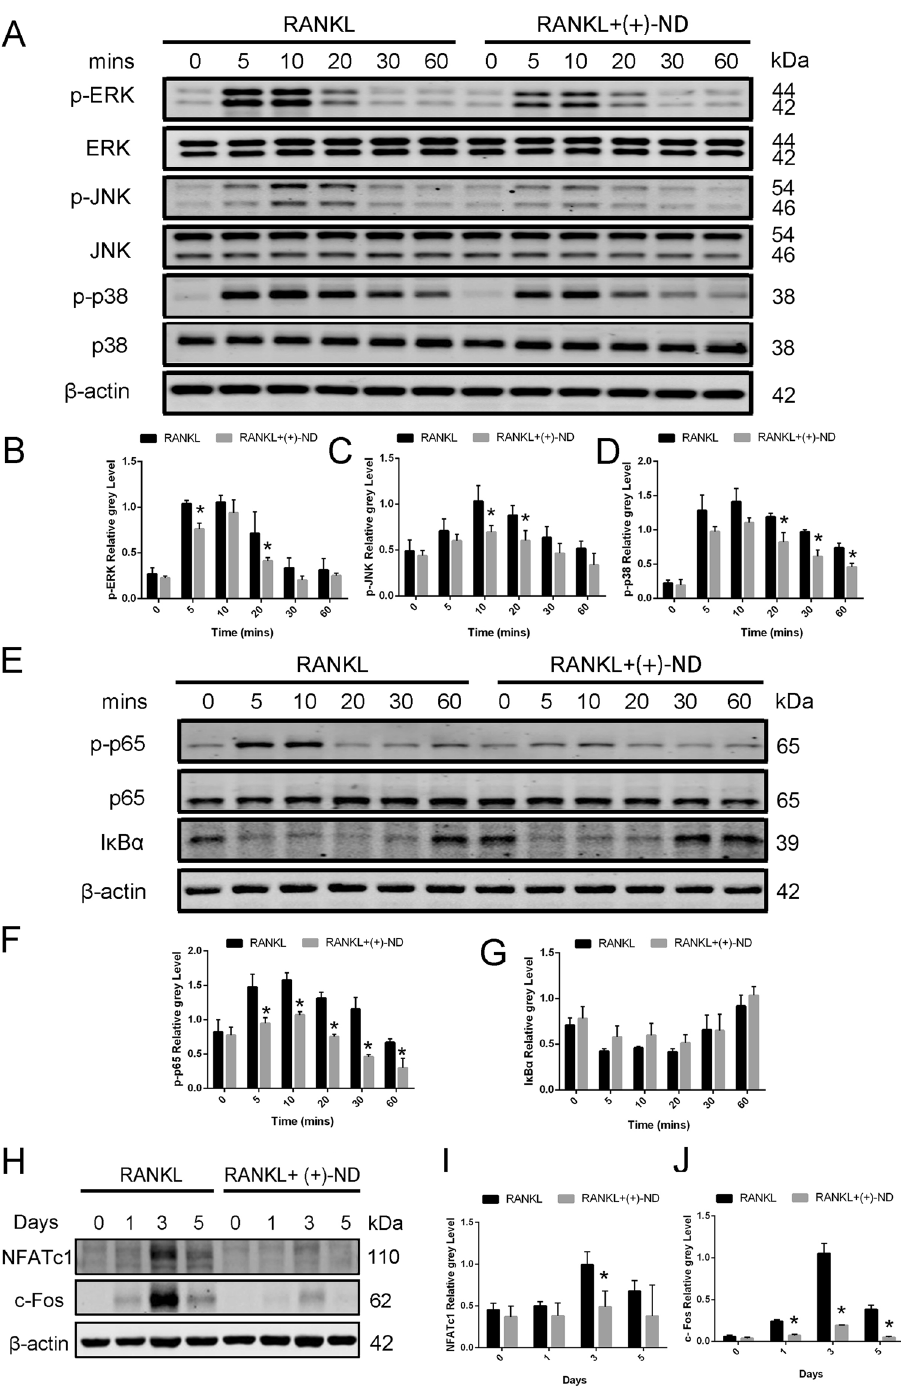
Fig. 6 ( + )-ND represses the activation of MARK and NF- κ B pathways by RANKL stimulation. A We pretreated BMMS with or without ( + )-ND (50 nM) in serum-free medium for 2 h. Thereafter, RANKL (50 ng/mL) was employed to stimulate cells. Western Blotting was carried out with speci fi c antibodies against p-ERK, ERK, p-JNK, JNK, p-p38, p38 to analyze cell lysates. Total β -actin was employed as the loading control. Representation of the ratio of p-ERK versus ERK ( B ), p-JNK versus JNK ( C ), p-p38 versus p38 ( D ) were shown. Band intensity was determined by Image J. E The activity of NF- κ B signal pathway was evaluated by Western Blotting and β -actin was employed as the loading control. The ratio of p-p65 versus p65 ( F ), and I κ B α versus β -actin ( G ) were quanti fi ed using Image J. H BMMs were exposed to ( + )-ND (50 nM) for 0, 1, 3, and 5 d. Cell lysates were explored via Western Blotting with distinct antibodies against NFATc1 and c-Fos. Total β -actin was employed as the loading control. The protein expression contents of NFATc1 ( I ) and c-Fos ( J ) were quanti fi ed by Image J. The data were con fi rmed at least three times ( * P < 0.05 relative to the control group at indicated times).